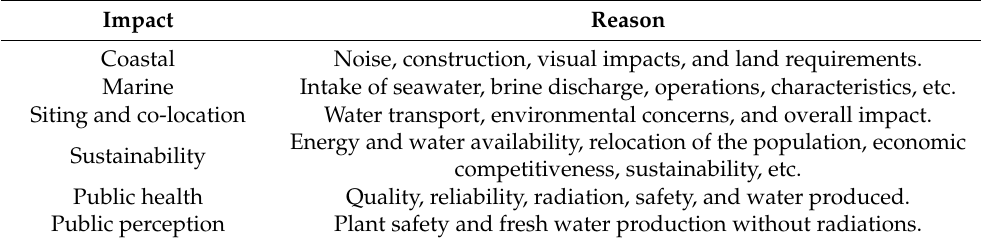
Table 4. Summary of the main environmental impacts of nuclear desalination. Impact Reason Coastal Noise, construction, visual impacts, and land requirements. Marine Intake of seawater, brine discharge, operations, characteristics, etc. Siting and co-location Water transport, environmental concerns, and overall impact. Energy and water availability, relocation of the population, economic Sustainability competitiveness, sustainability, etc. Public health Quality, reliability, radiation, safety, and water produced. Public perception Plant safety and fresh water production without